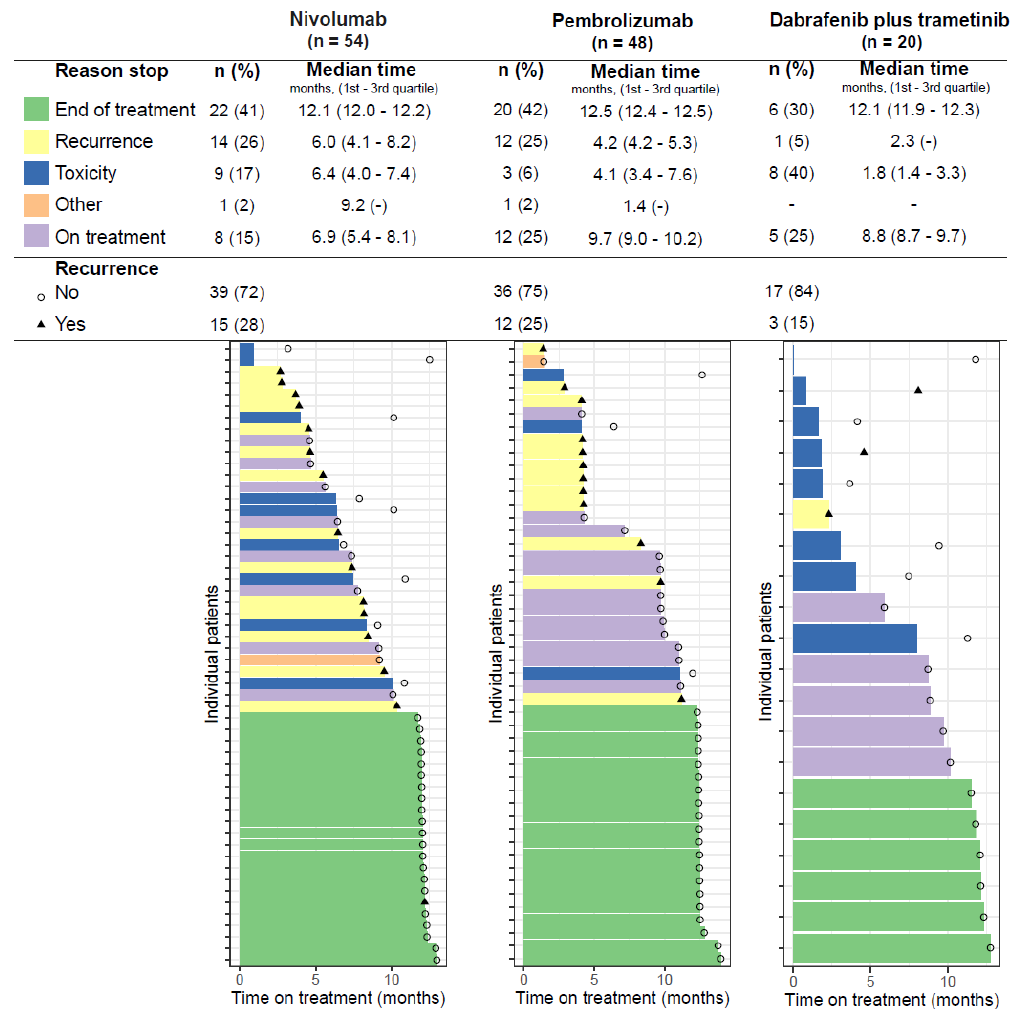
Figure 3. Patients’ time on treatment, causes of treatment discontinuation, and recurrence per treat ‐ ment. Table 3. Adverse